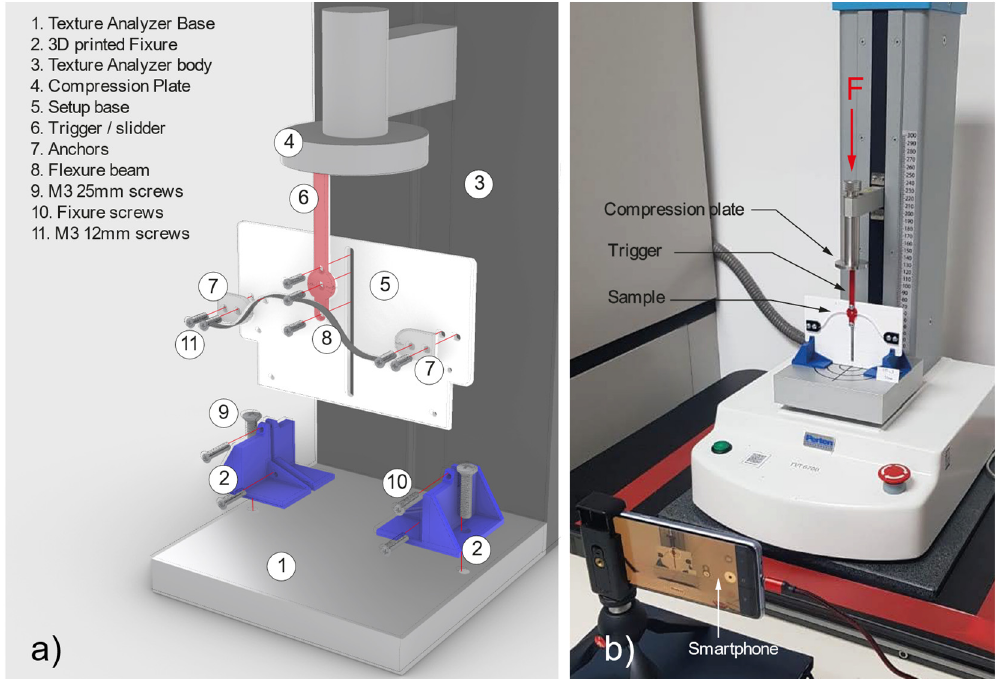
Figure 3. ( a ) Enlarged 3D model of the setup on the texture analyzer. ( b ) Picture of the setup placed on the texture analyzer. All of the experiments were documented using a smartphone.